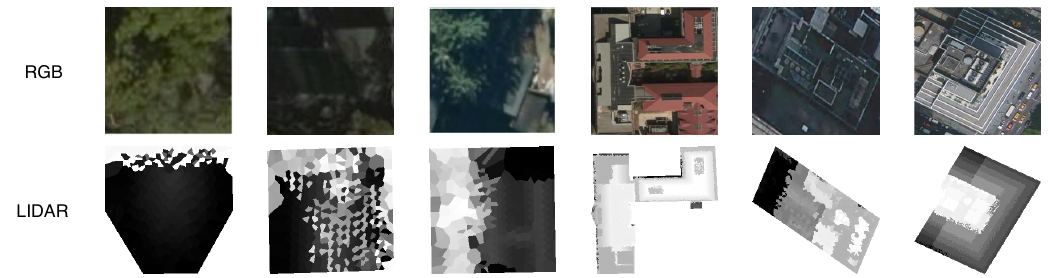
Figure 9. RGB and LiDAR example images classified as unknown . This category includes buildings with poor quality images as well as complex roof structures.